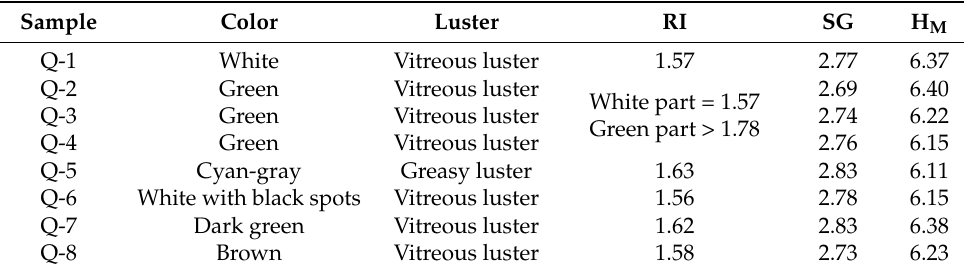
Table 1. Gemological properties of the Philippines rock